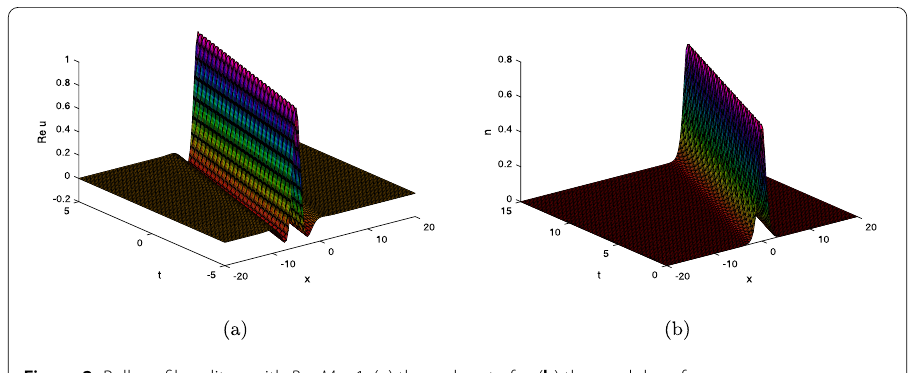
Figure 2 Bell-profile soliton with B = M = 1: ( a ) the real part of u ; ( b ) the modulus of